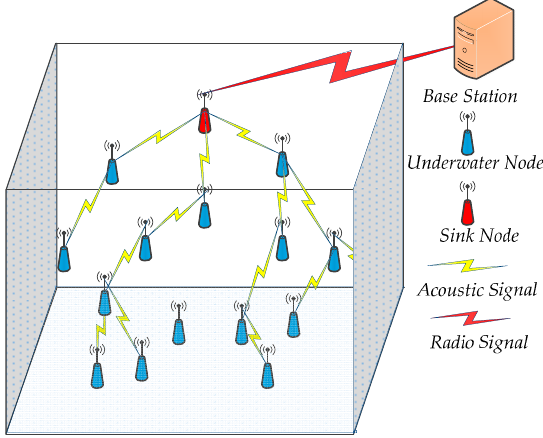
Figure 1. 3D UWSNs system model.